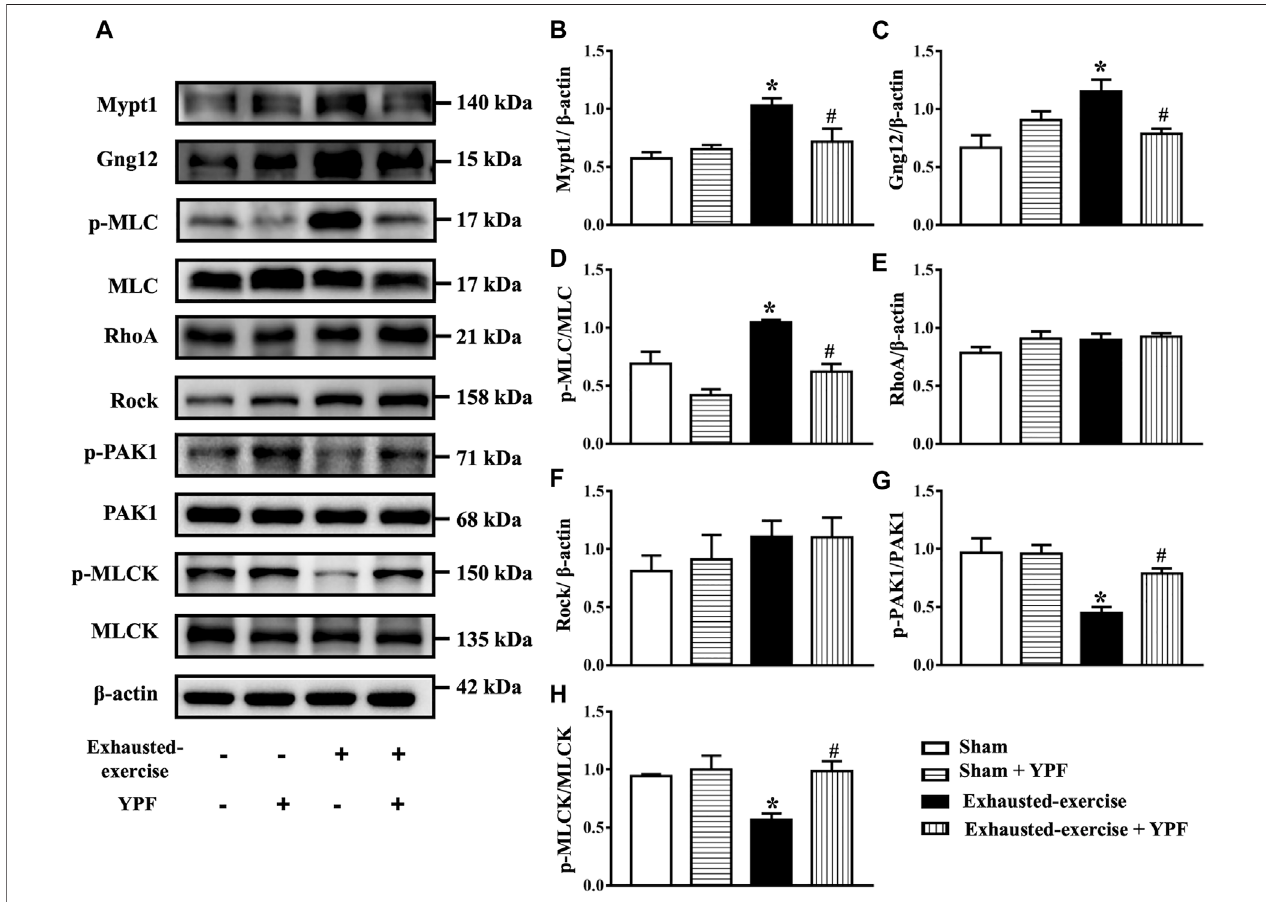
FIGURE 6 | YPF attenuates the alteration of MLC and related signaling proteins after exhausted exercise. (A) Representative Western bands of Mypt1, Gng12, p-MLC, MLC, RhoA, Rock, p-PAK1, PAK1, p-MLCK, and MLCK. (B – H) Semi-quantitative analysis of (B) Mypt1, (C) Gng12 (D) p-MLC/MLC, (E) RhoA, (F) Rock, (G) , p-PAK1/PAK1, and (H) p-MLCK/MLCK . Results are presented as means ± SEM ( n = 4). * p < 0.05 vs. sham; # p < 0.05 vs. exhausted-exercise.